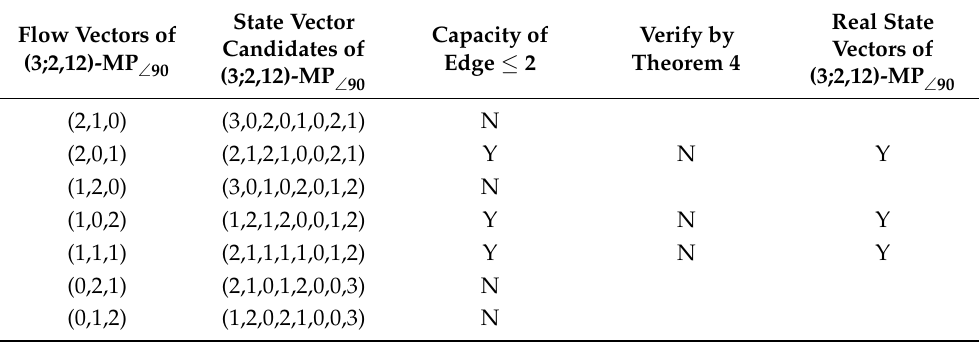
Table 6. The real state vector of (3;2,12)-MP ∠ 90 .